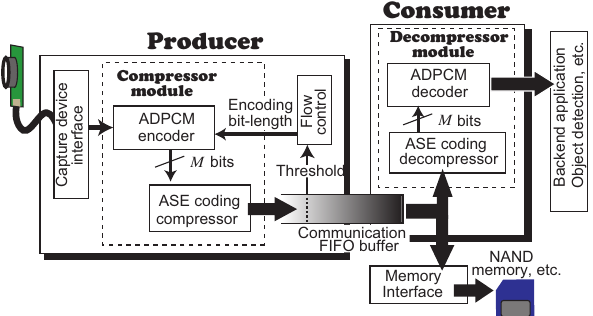
Figure 3. The system model for the visually lossless video